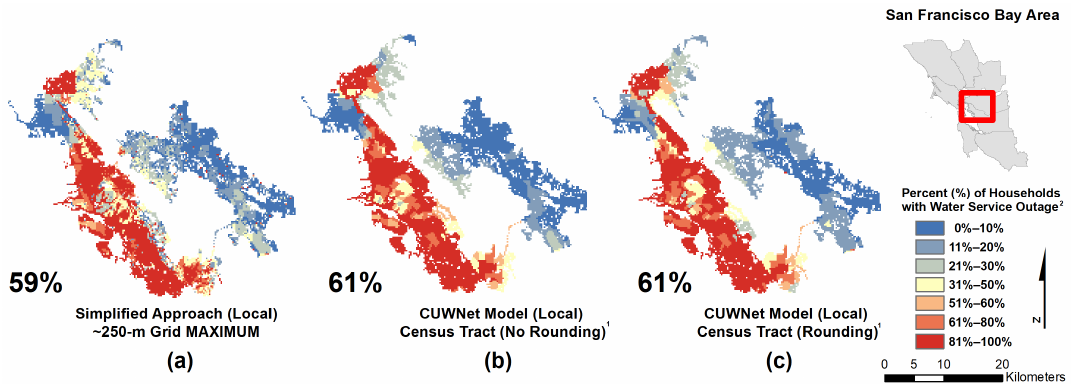
Figure 7. Sensitivity analysis comparisons, water service outage: ( a ) simplified approach, with CUWNet model results ( b ) CUWNet model with census tracts, no rounding ( c ) and rounding. 1 Equivalent to Hazus loss estimation at the Census tract scale, with Porter [1] vulnerability function. 2 The global serviceability results are calculated over the study region and so cannot be shown geographically.